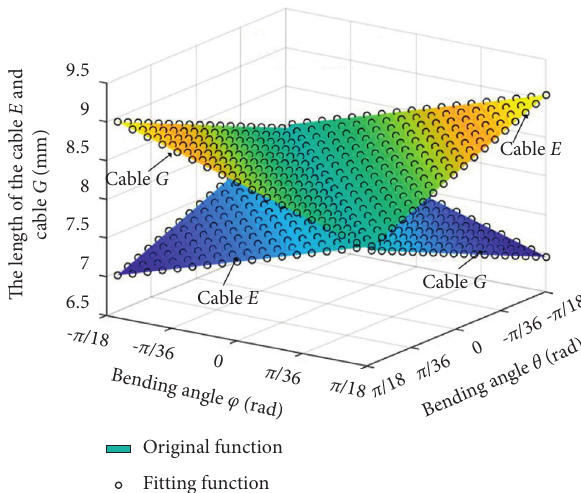
Figure 11: Kinematics linear fitting analysis of cable E and cable